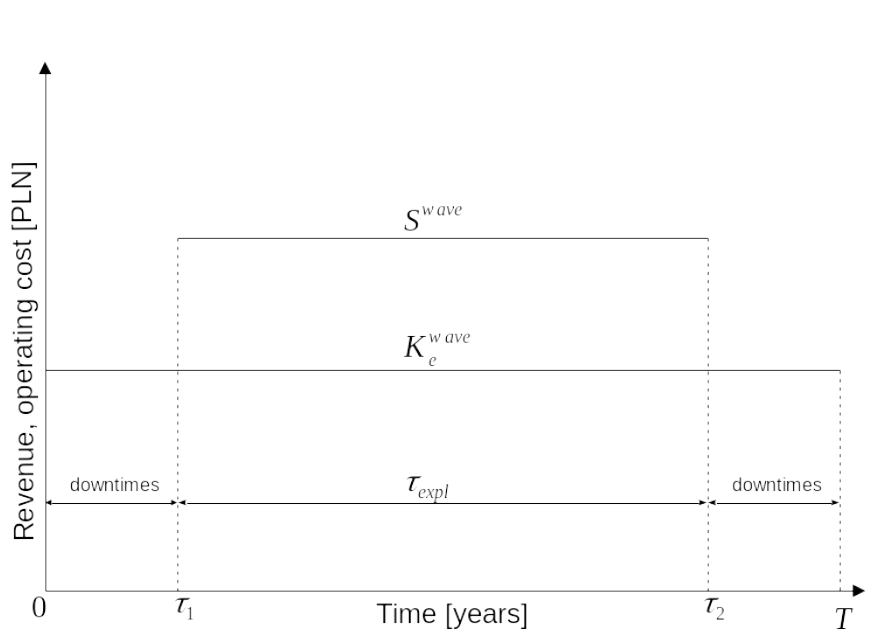
Figure 2. Time course of the weighted average operating costs and revenues gained from renewable energy sources